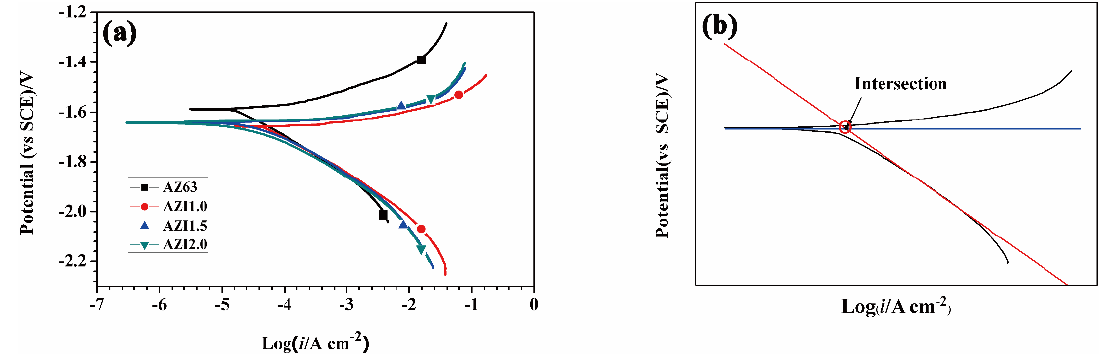
Figure 6. Potentiodynamic polarization curves of AZ63 and AZI alloys after 1 h immersion in 3.5 wt% NaCl at 25 ± 1 °C ( a ) and sketch map of polarization curve for Tafel extrapolation ( b ).